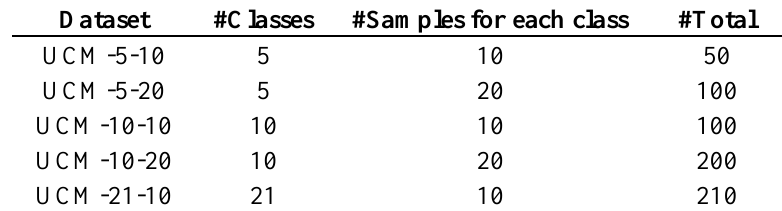
Table 3. Sub-dataset